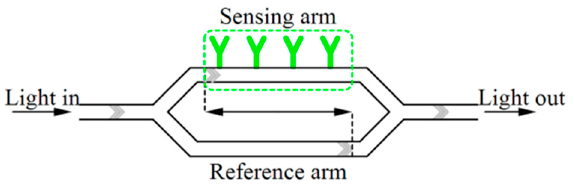
Figure 7. An MZI Figure 7. ( a ) An MZI sensor.